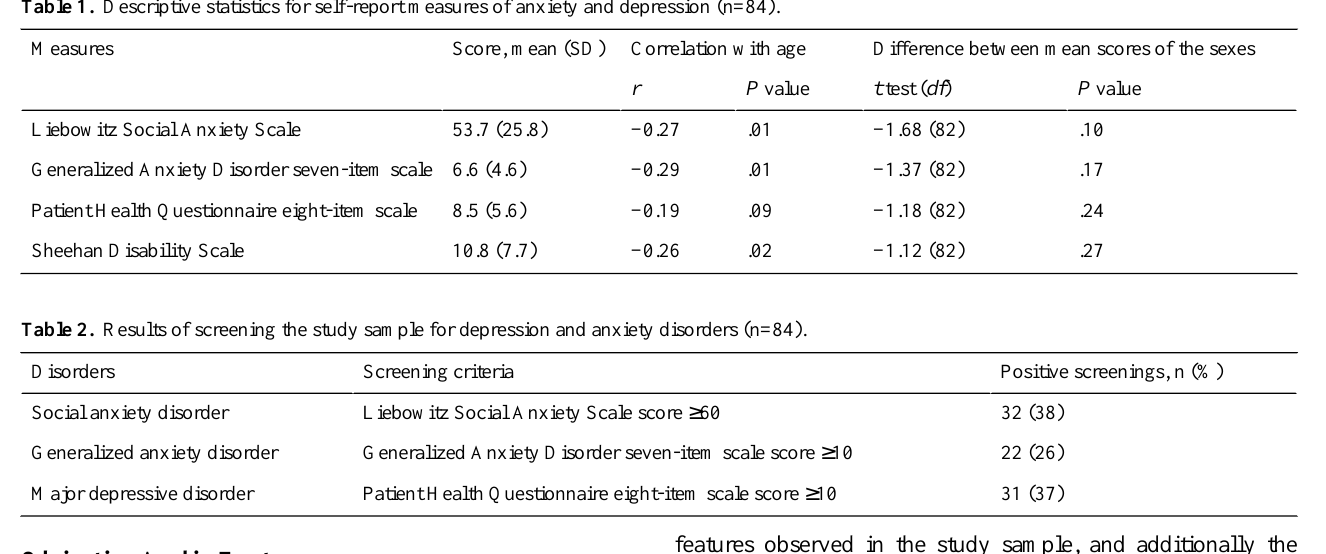
Table 1. Descriptive statistics for self-report measures of anxiety and depression (n=84).